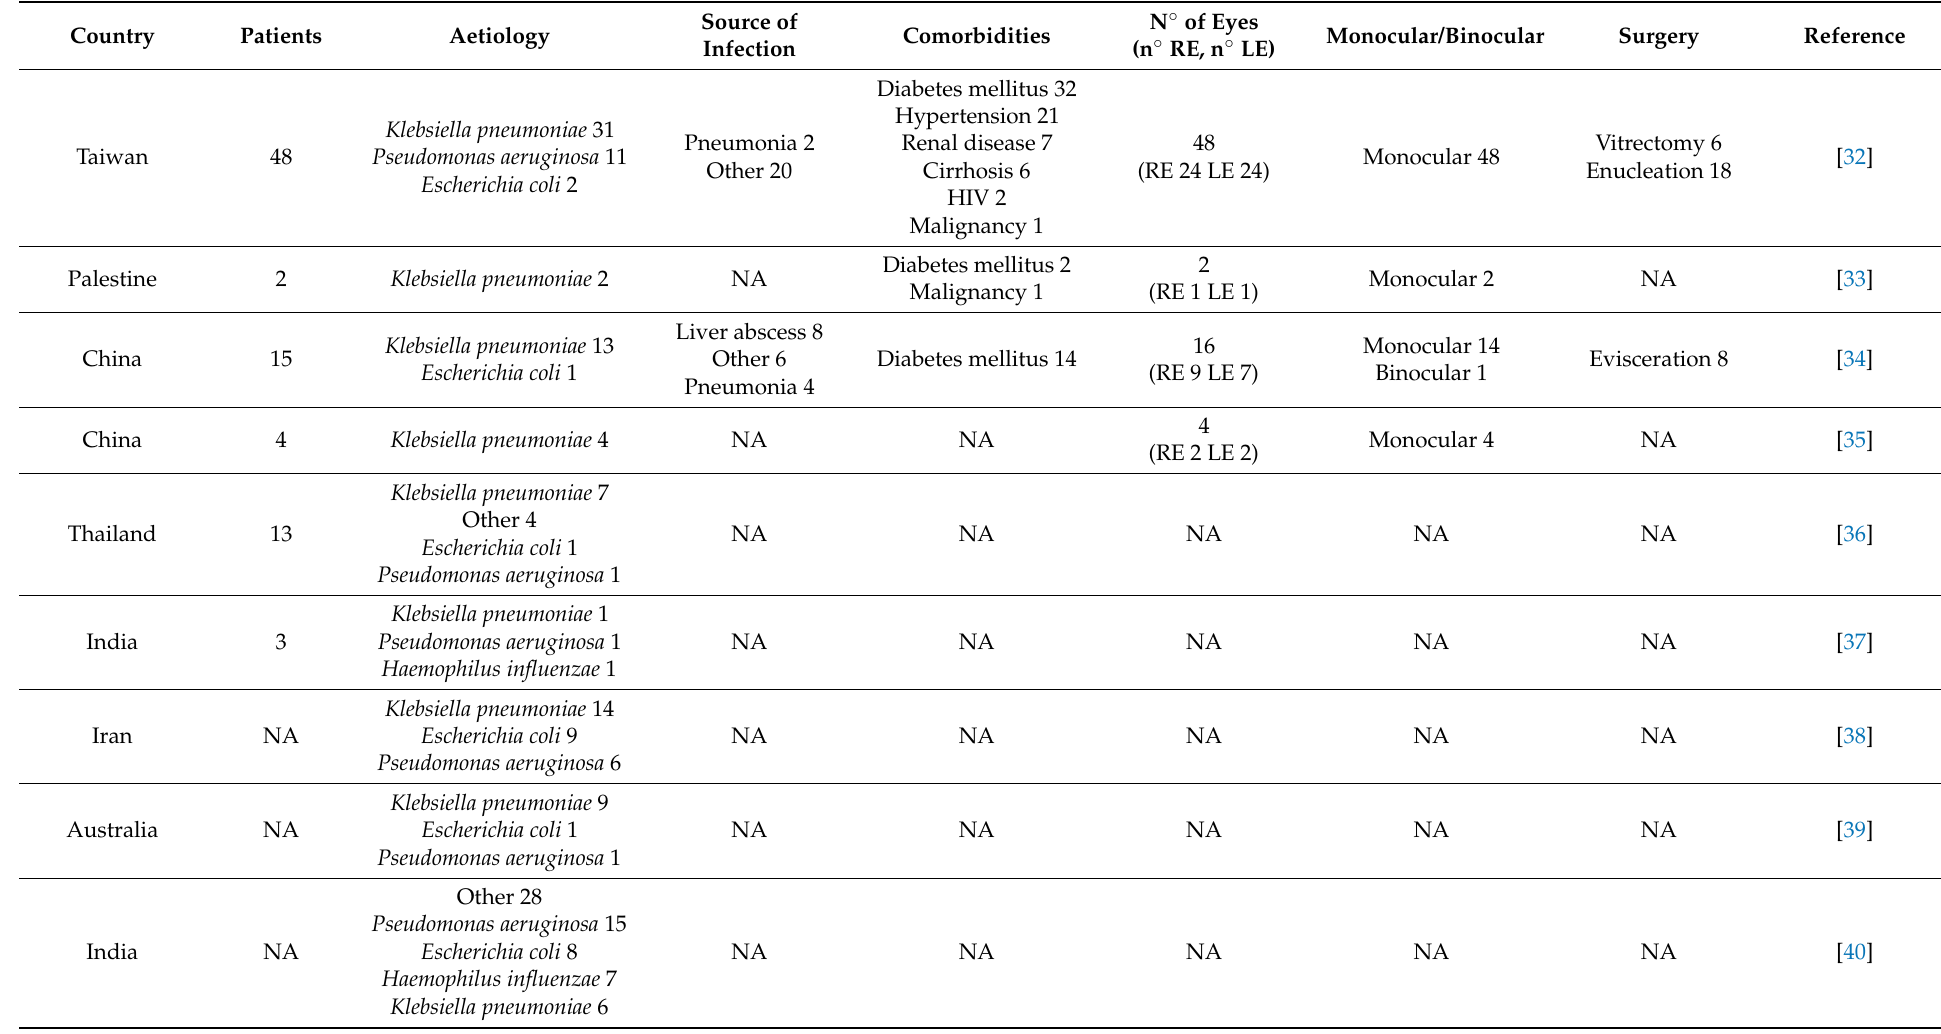
Table 1. Summary table regarding study characteristics, aetiologic data and patients’